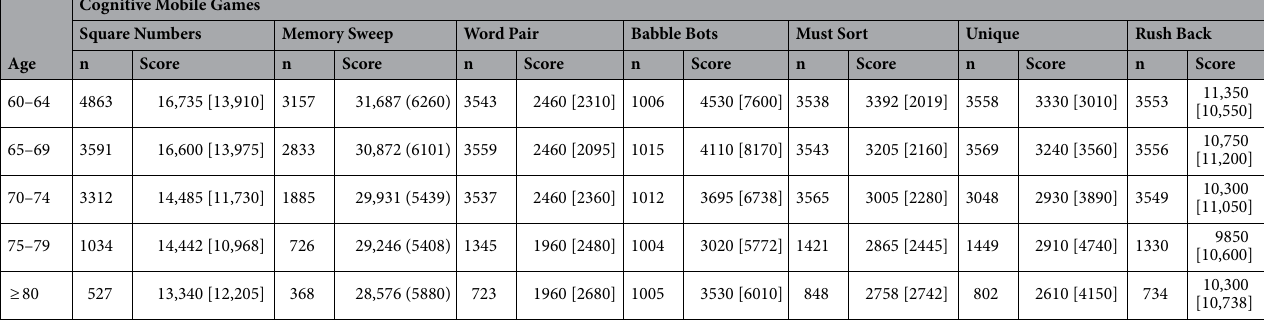
Table 1. Number of subjects in each age group (n) and mean (SD) or median [IQR] scores for the different CMG according to the age of the participants for the first session of